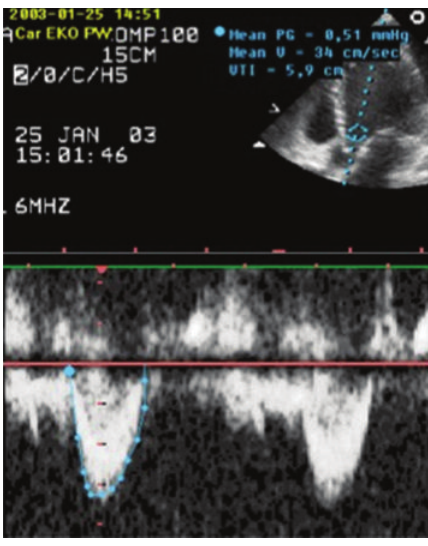
Figure 5: Measurement of LVOT VTI from the apical 5-chamber